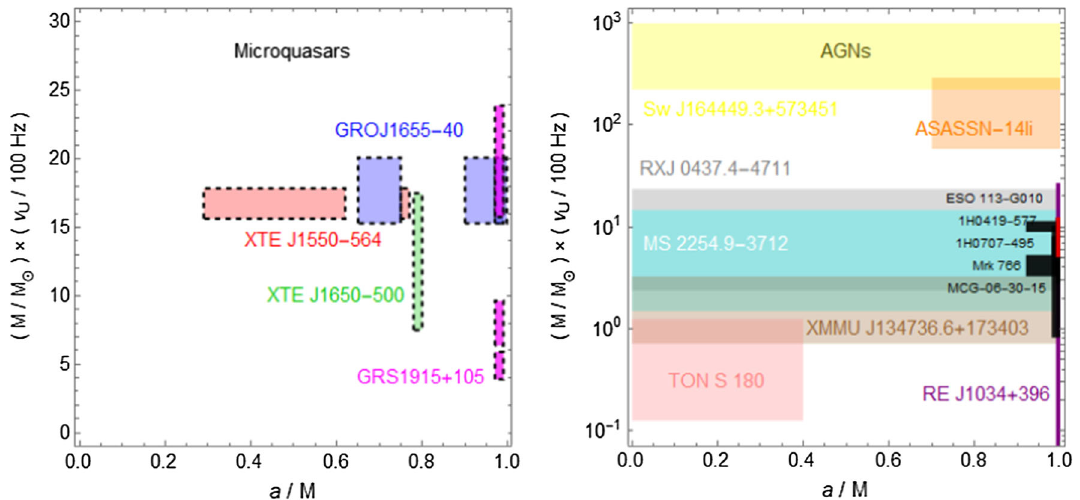
Fig. 4 The position of Quasars, and AGNs depending on the prod- uct of mass and frequencies as well as the spin parameter a / M . The shaded regions represent the objects with mass estimates, often with large errors, but no spin estimates in the literature. The colored blocks